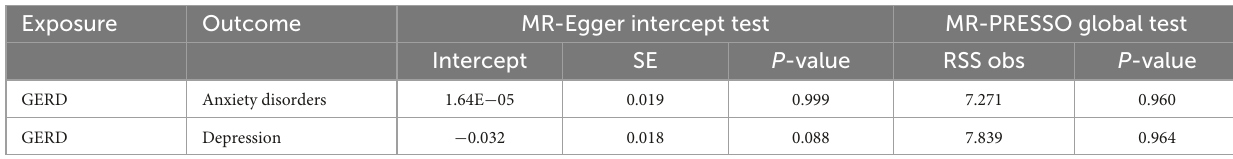
TABLE 5 Results of horizontal pleiotropy by the MR-Egger intercept test and MR-PRESSO global test (based on the IVs screened under the genome-wide significance threshold). Exposure